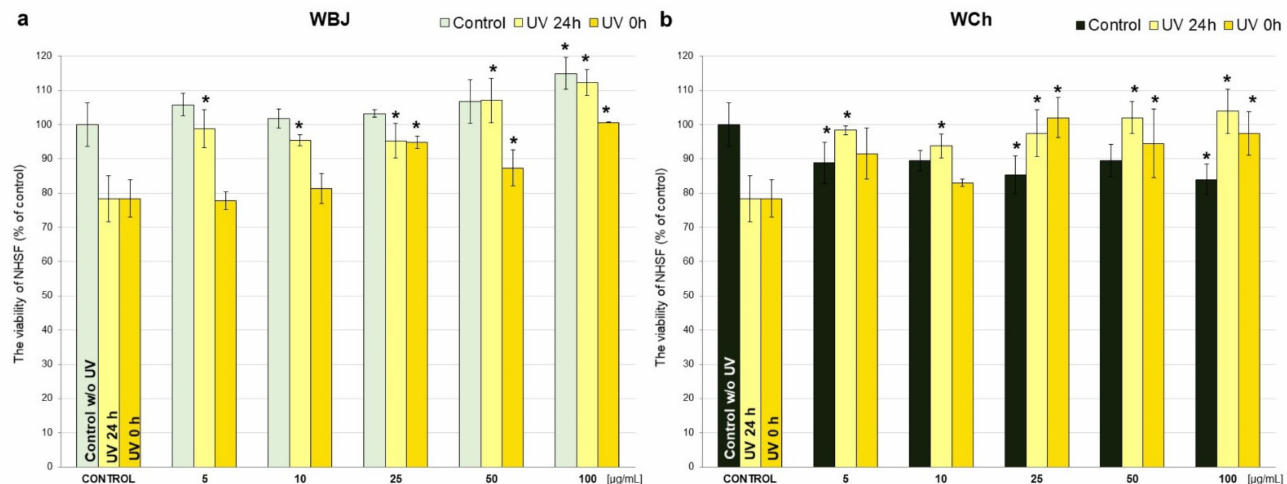
Figure 5. Effects of water extract of young barley juice (WBJ; ( a )) and chlorophyll (WCh; ( b )) at various concentrations (5, 10, 25, 50, 100 µ g/mL) on the viability of NHSF cells without and after application of UV radiation, after 48 h incubation. Results are presented as percentage of control. * p < 0.05—statistically significant difference from corresponding control. Statistically significant difference between particular doses of the tested extracts ( p < 0.05 WBJ 50 vs. WCh 50, WBJ 10 vs. WCh 10, WBJ 25 vs. WCh 25, WBJ 100 vs. WCh